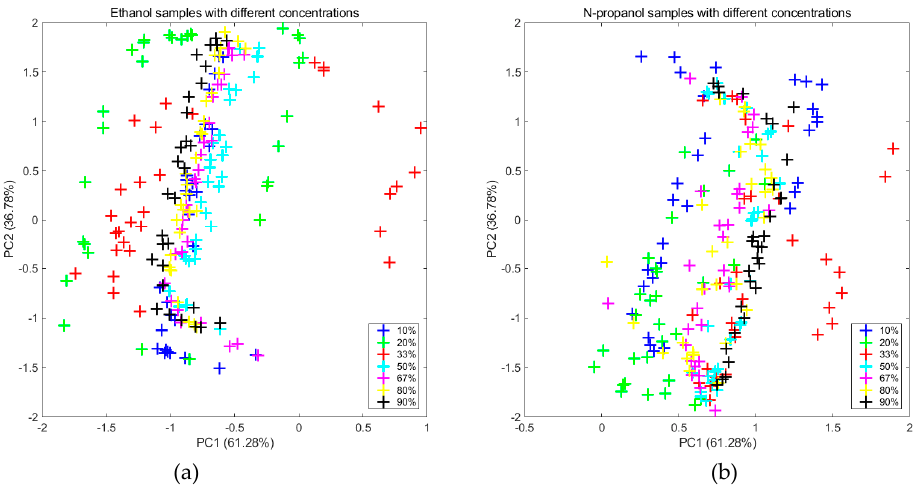
Figure 3. Projections of the two first primary components of the PCA computed for the two new feature datasets which were transformed from the original data by the MICF.: ( a ) ethanol and ( b ) n-propanol.